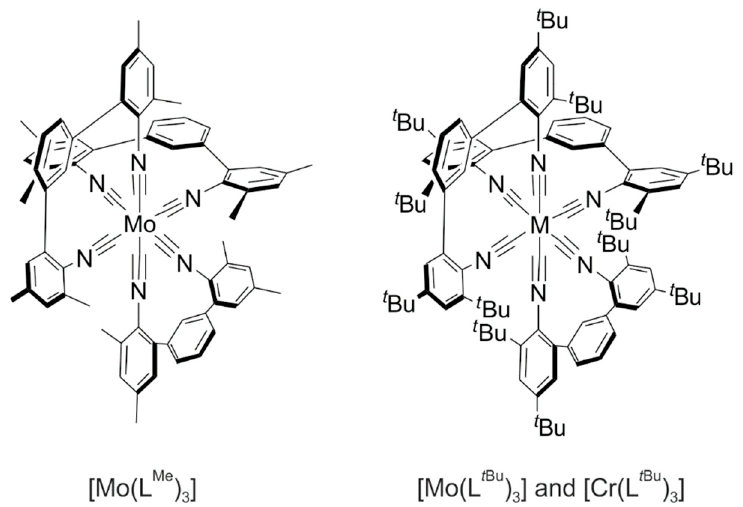
Figure 1. Molecular structures of Cr 0 and Mo 0 complexes with diisocyanide chelate ligands Figure1. MolecularstructuresofCr 0 andMo 0 [17,24,25,27].